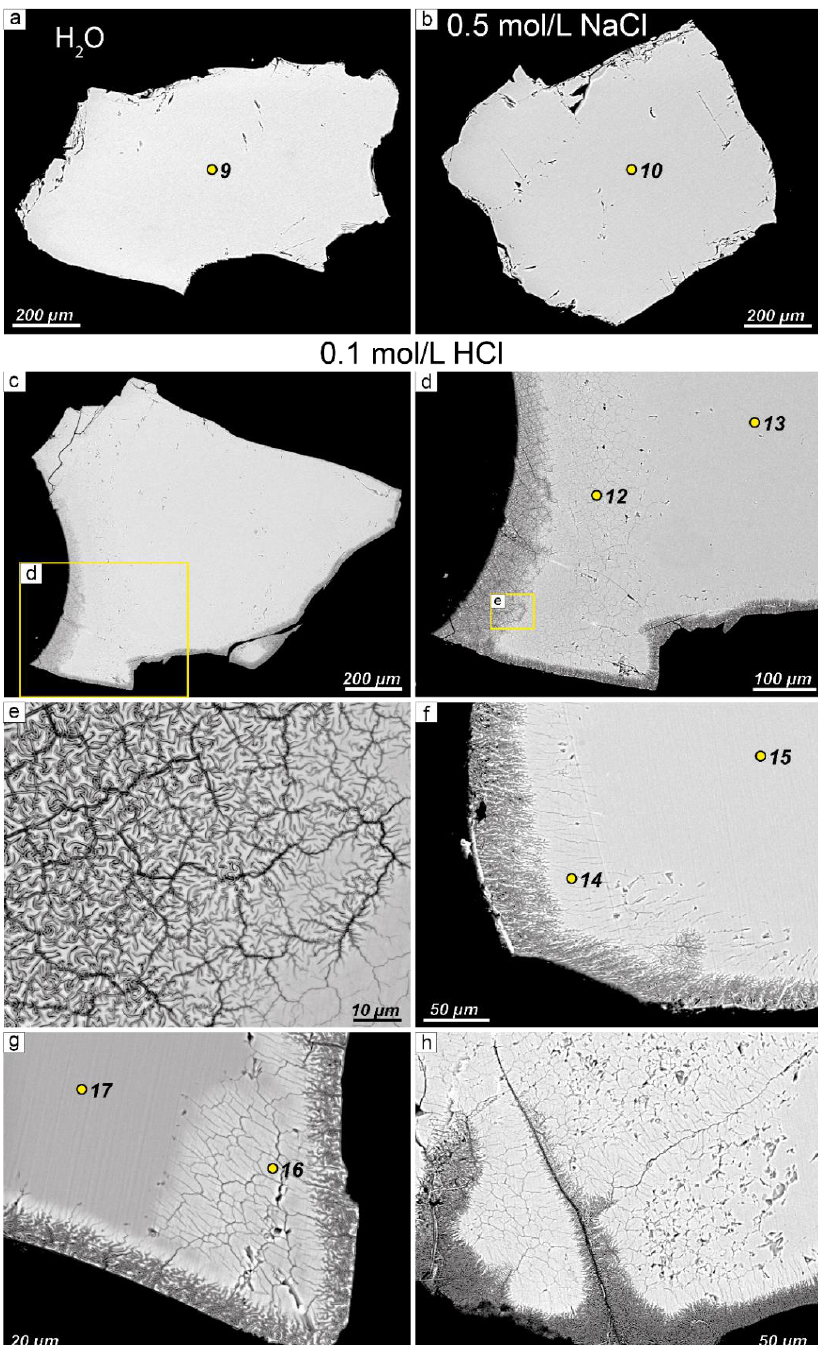
Figure 6. BSE images of the morphology of EGM grains after experiments. ( a ) EGM grain after experiment with deionized water (experiment time = 40 days); ( b ) after experiment with 0.5 mol/L NaCl solution (experiment time = 40 days); ( c ) after experiment with 0.1 mol/L HCl solution (experiment time = 10 days); grain is surrounded by a zonal rim consisting of Si-Zr phases and sodium-depleted EGM. Detailed image of the fragments: ( d ) shown in Figure 6c; ( e ) shown in Figure 6d. The fragments of EGM grain: ( f ) after experiment with 0.1 mol/L HCl solution (experiment time = 20 days); zonal rim about 100 μm across surrounding the EGM grain is clearly visible; ( g ) after experiment with 0.1 mol/L HCl solution (experiment time = 30 days); ( h ) after experiment with 0.1 mol/L HCl solution (experiment time = 30 days). Yellow dots (9 – 17) are microprobe analysis points (see Tables 4 and 5).